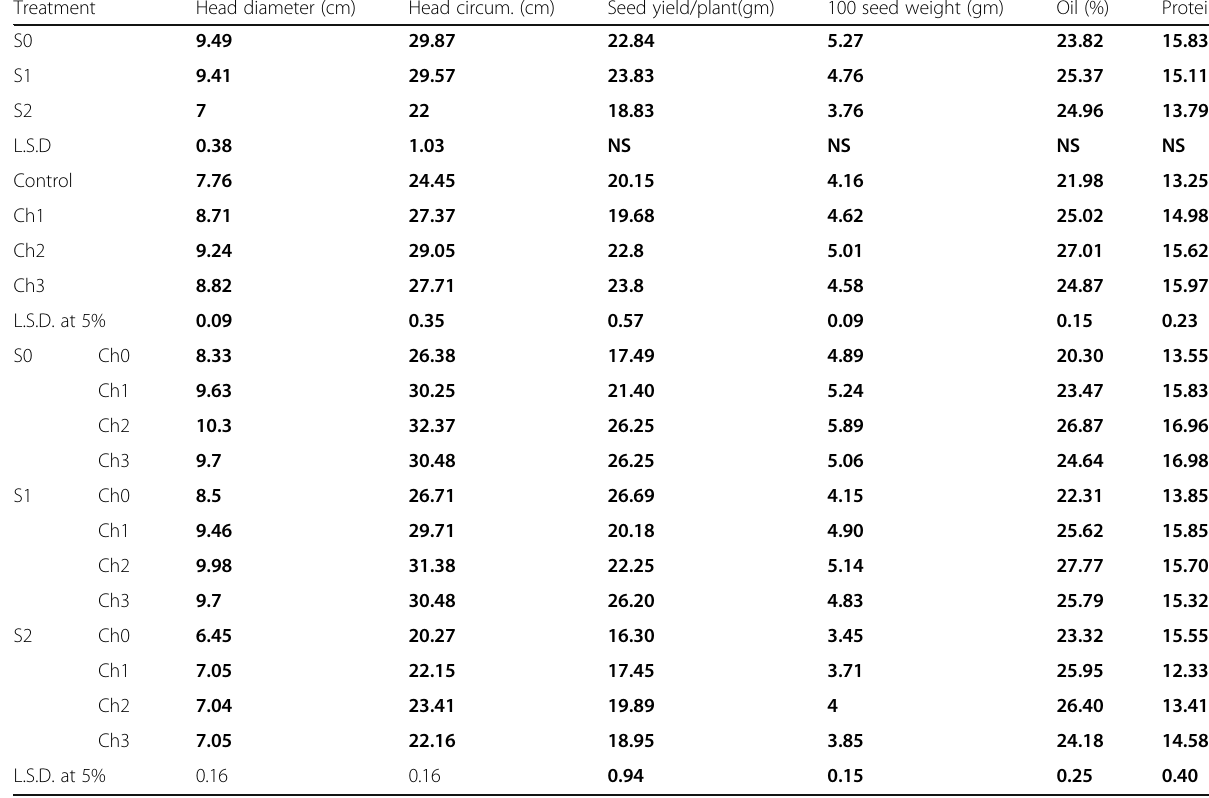
Table 4 Effect of salt stress, chitosan and their interaction on concentration on yield and its attributes of sunflower plants